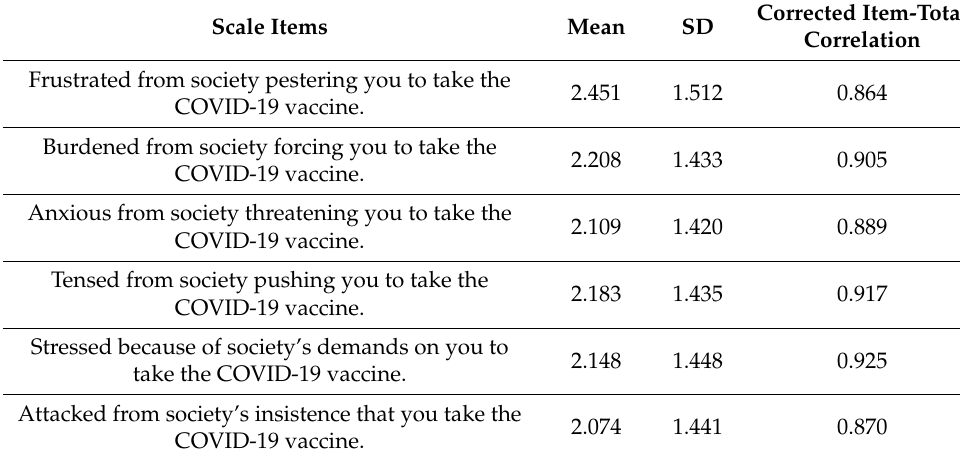
Corrected Item-Total